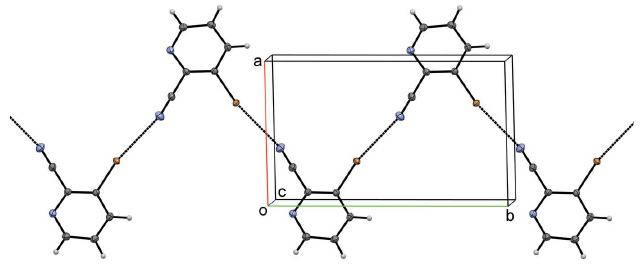
Figure 2 Partial packing diagram of the title compound showing the inter- molecular Br (cid:2)(cid:2)(cid:2) N contacts as dashed lines. Displacement ellipsoids are drawn at the 30% probability level.